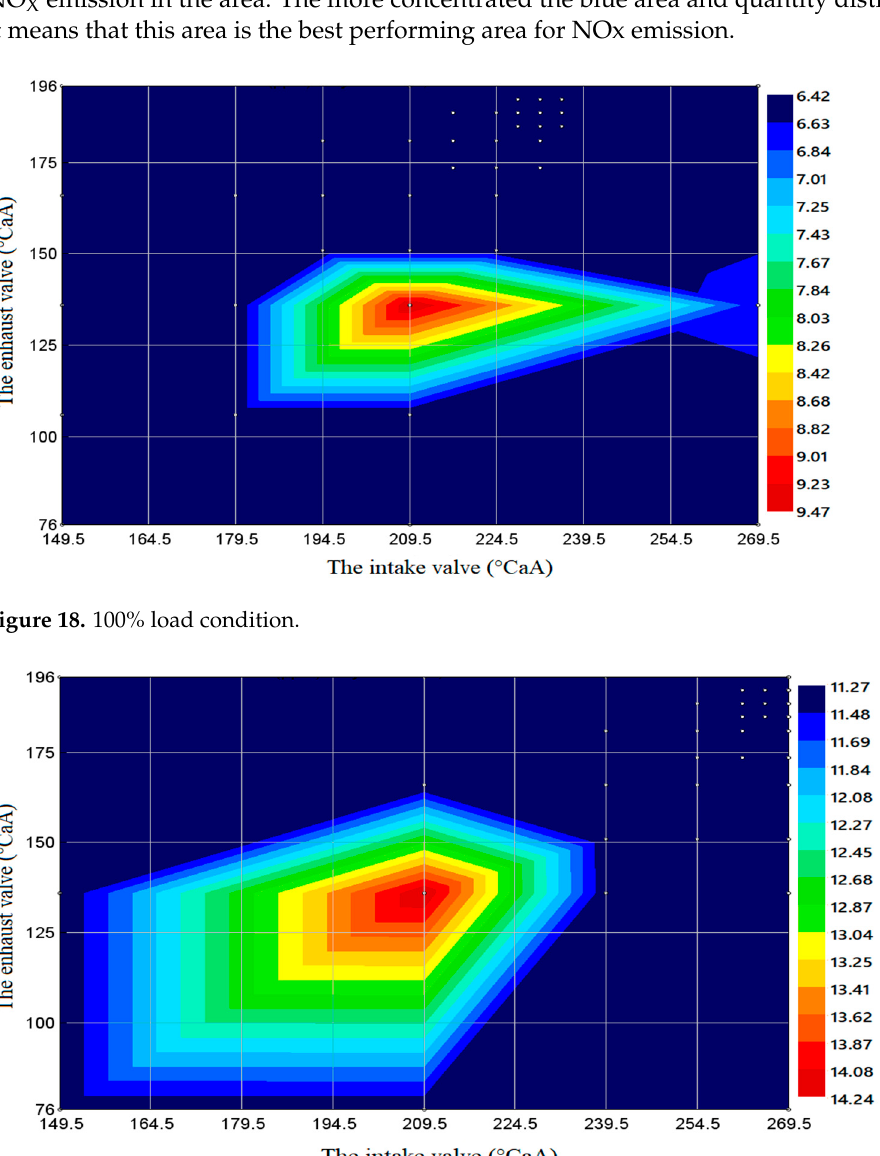
Figure 17. Comparison of improved soot emissions with original values at 100% and 50% load.